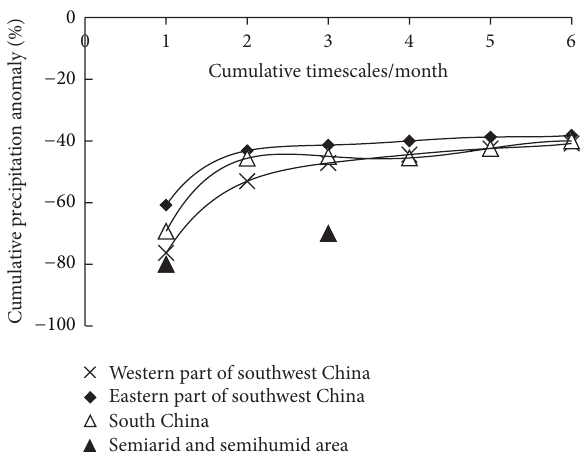
Figure 10: Relationship between cumulative timescales and cumu- lative precipitation deficit in different